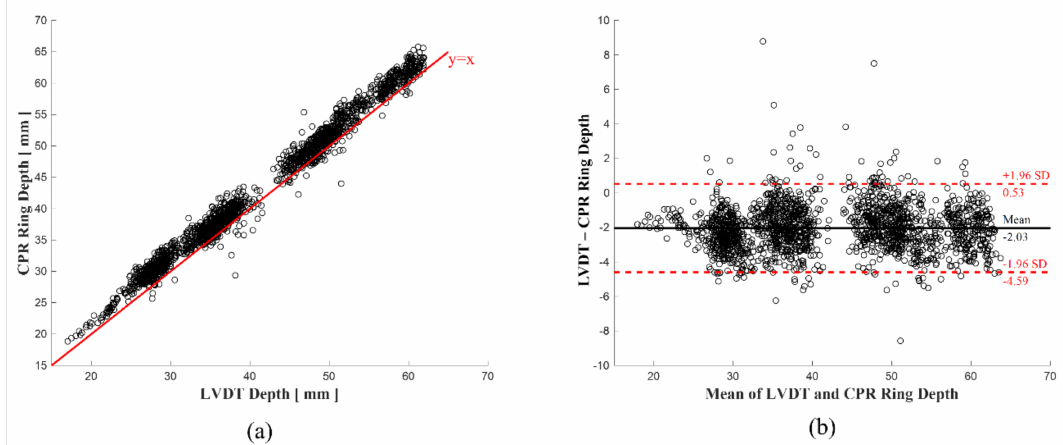
Figure 7. Comparison of reference (LVDT) and feedback algorithms. ( a ) Scatter plot, ( b ) Bland–Altman Plot.